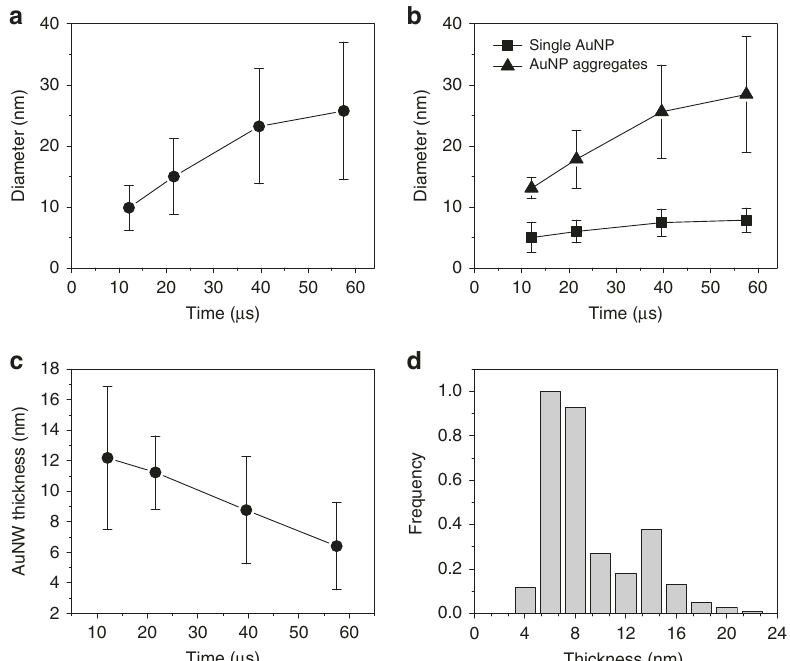
Fig. 5 Kinetics of AuNPs and AuNWs growth in the reducing-agent- and template-free microdroplets. a The diameter of AuNP aggregates as a function of time in the microdroplets. b The change in the diameters of individual AuNP and AuNP aggregates over time. c The change in the thickness of AuNW over time. d The bimodal distribution of the thickness of AuNWs formed in the microdroplets. Error bar represents standard deviation of the three